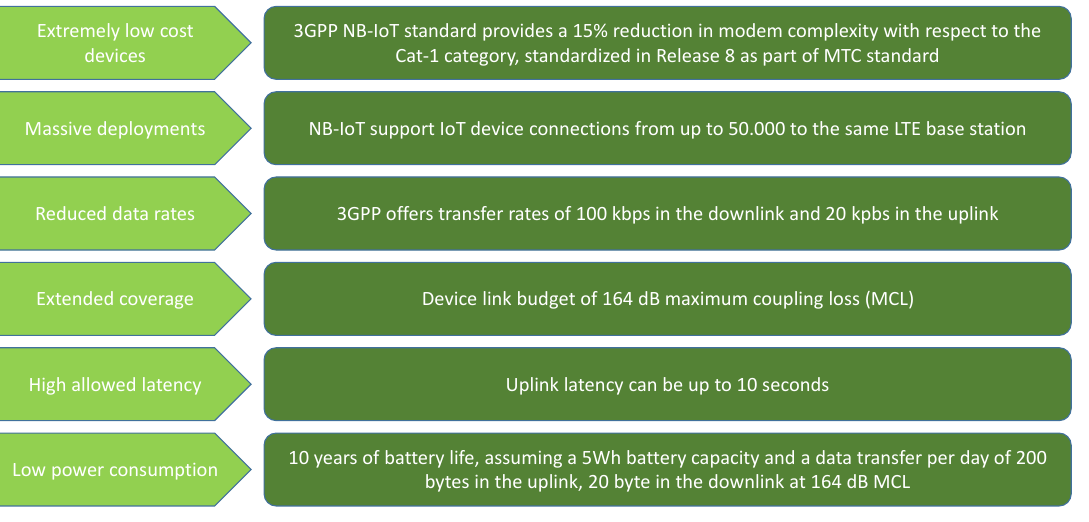
Figure 1. NB-IoT in